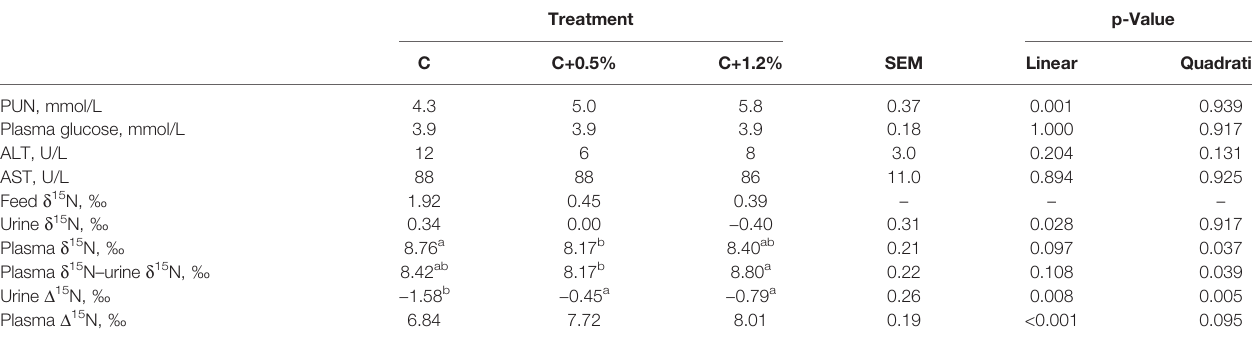
TABLE 3 | Plasma urea nitrogen (PUN), plasma glucose, and natural enrichment of N-15 in feed, urine, and plasma, and nitrogen isotopic discrimination ( D 15 N) of sheep offered three different levels of non-protein N. Treatment p-Value C+0.5% Linear